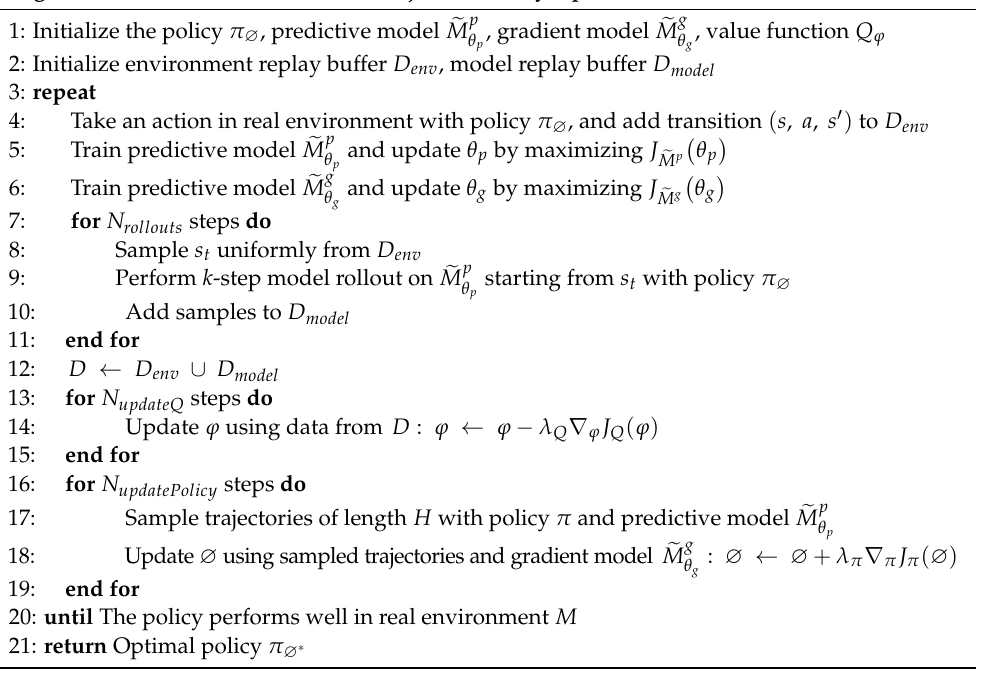
Algorithm 1 Directional Derivative Projection Policy